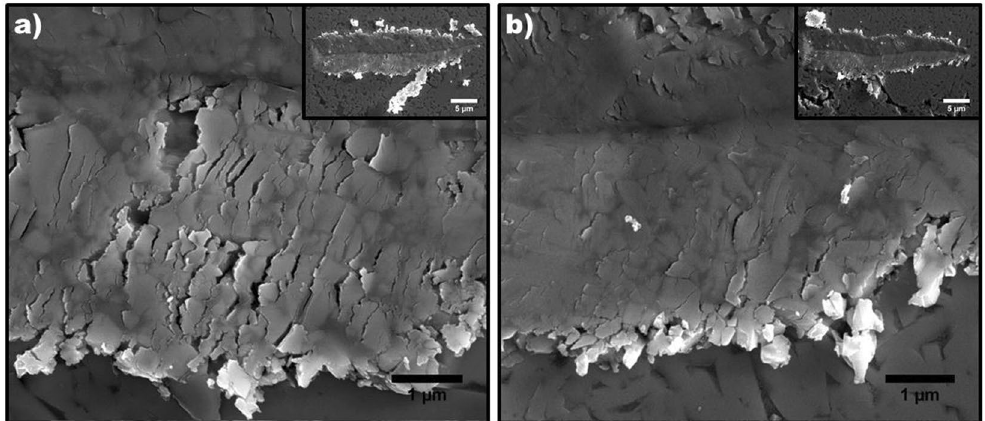
Figure 8. SEM of micro scratch grooves; ( a ) WC-Co scratch groove exhibits significant cracking, indicative of an embrittled binder, inset: lower magnification image of a WC-Co scratch groove exhibiting cracking and large debris particle, ( b ) WC-Co-10ND scratch groove does not exhibit any significant cracking, groove is smooth indicative of a ductile binder, inset: lower magnification image of a WC-Co-10ND scratch groove showing significantly reduced cracking and